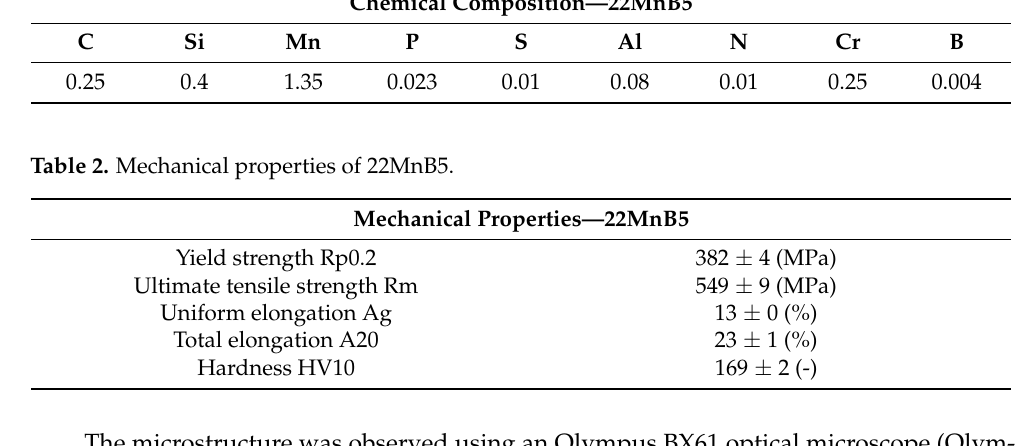
Table 1. Chemical composition of 22MnB5 (wt.%).